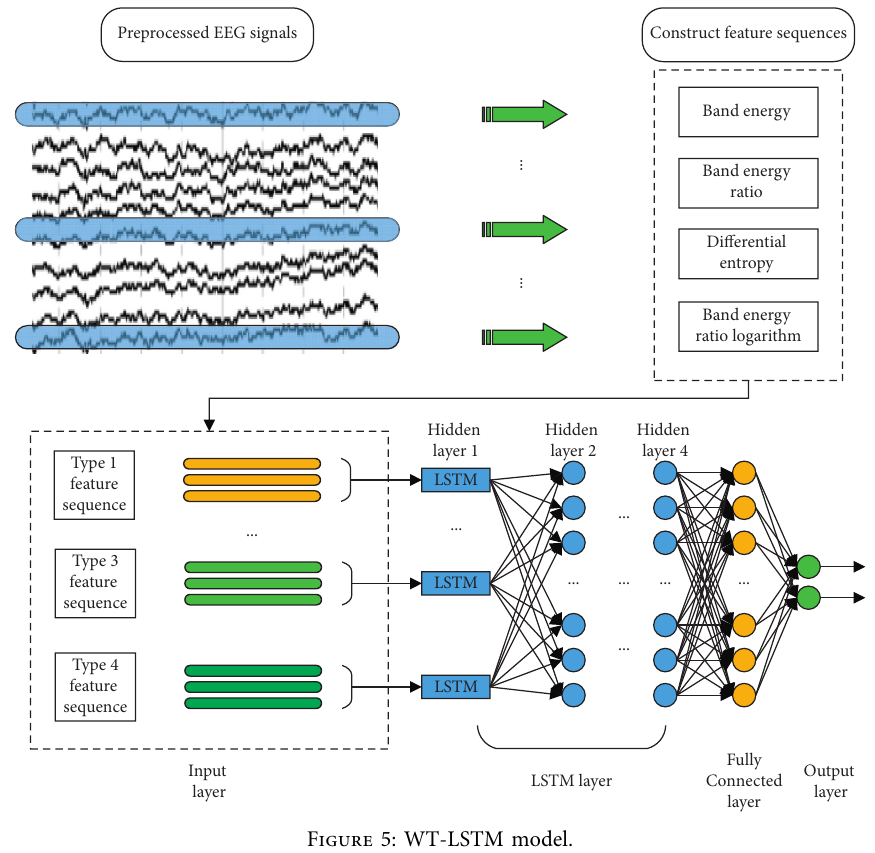
Figure 5: WT-LSTM model.